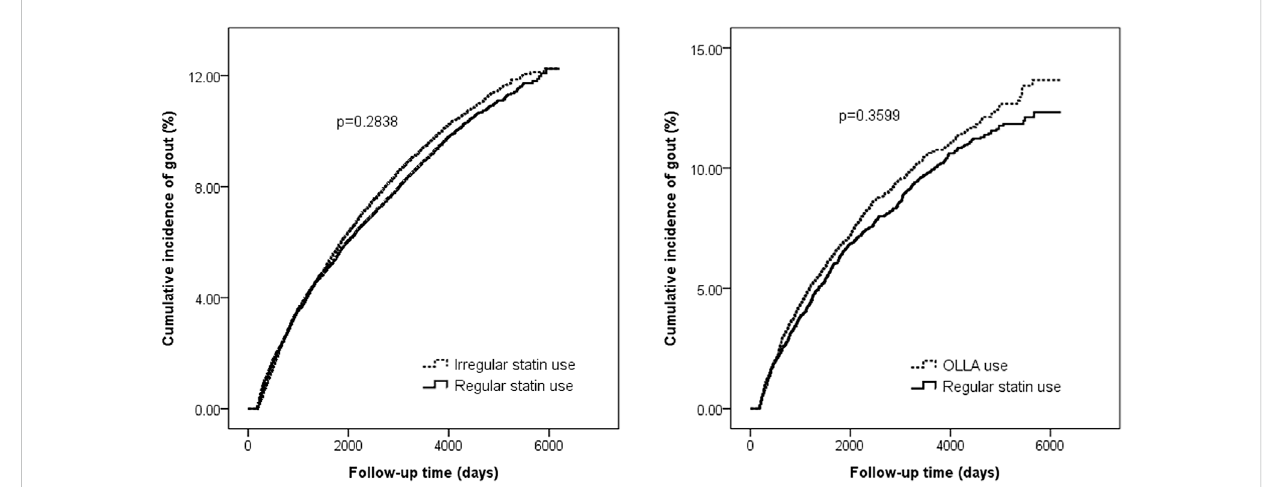
FIGURE 2 Cumulative incidence of gout in 2 main cohorts. OLLA, other lipid-lowering agent.